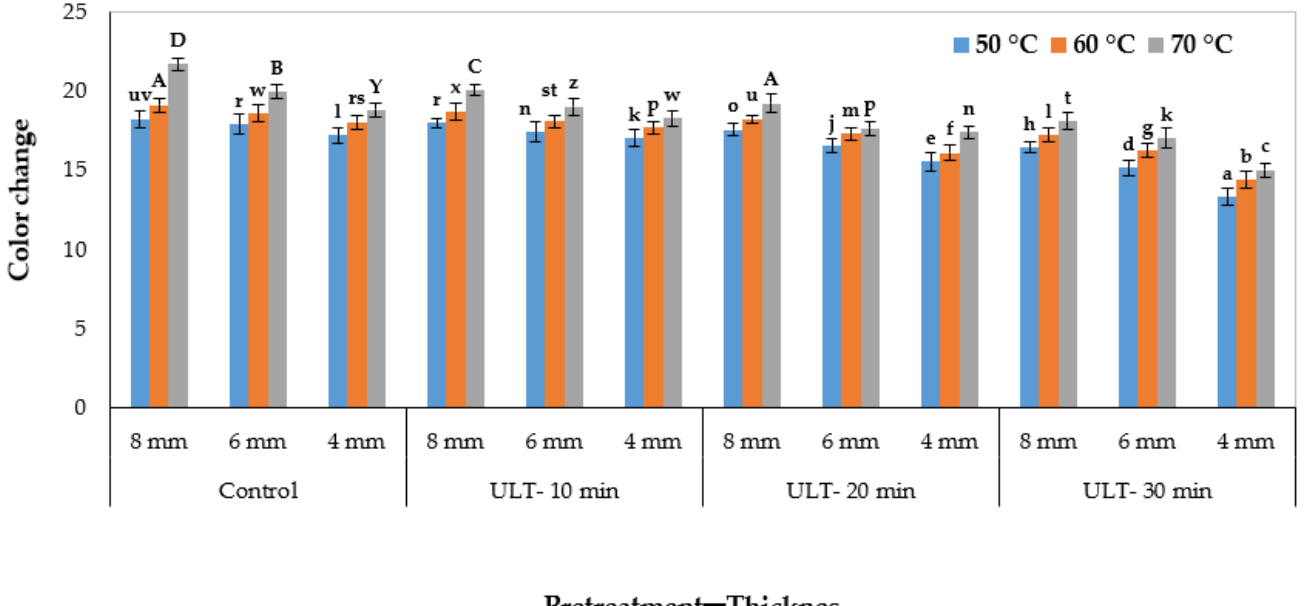
Figure 7. Color changes of kiwifruit slices under different drying conditions.